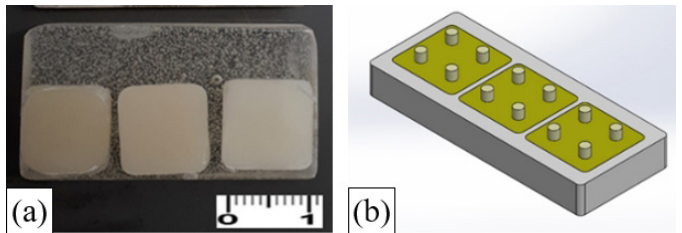
Figure 1. (a) Samples of lithium disilicate embedded in acrylic resin for shear test; (b) schematic drawing of lithium disilicate glass- ceramic samples with resin cement cylinders bonded on the surface.